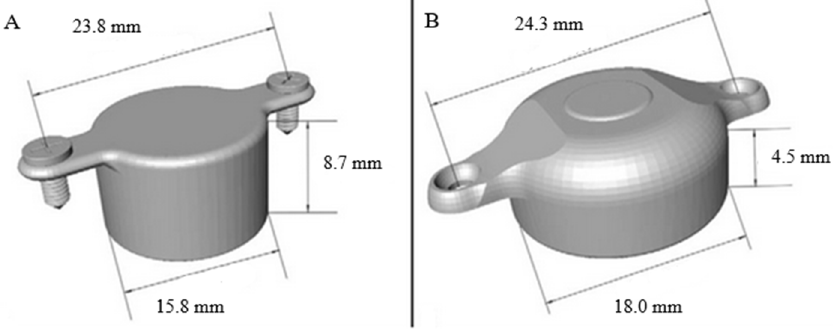
Figure 3. ( A )—Dimensions of the BCI 601; ( B )—dimensions of the BCI 602 [14].